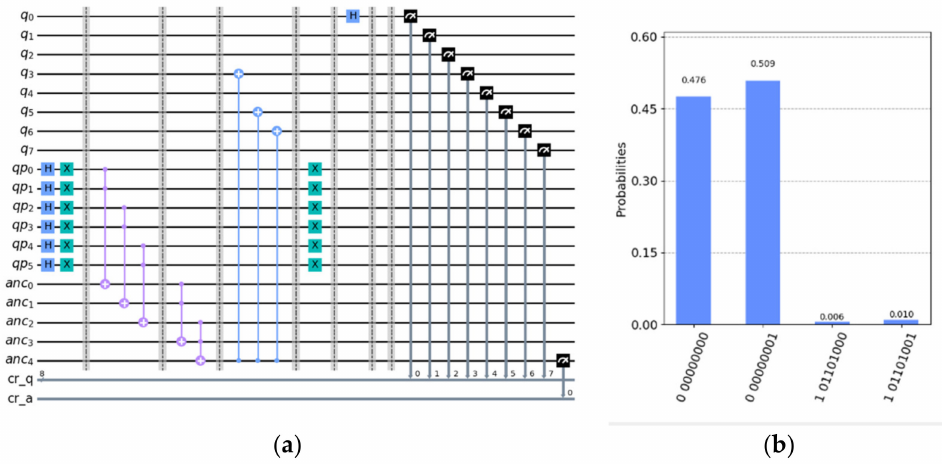
Figure 4. ( a ) The NEQR representation for the first pixel (gray level 104, LSB set to 0) is presented, along with the quantum gates, required for the measurement basis, added by the server, depending on the LSB from the images sent by Alice and Bob. For her first pixel, Alice encodes her qubit using the ( | + (cid:105) , |−(cid:105) ) basis, while Bob uses the computational basis ( | 0 (cid:105) , | 1 (cid:105) ) . ( b ) The probability for the states is presented; the results are obtained by running the circuit on the local simulator, with 1024 shots—the same applies to all of the following